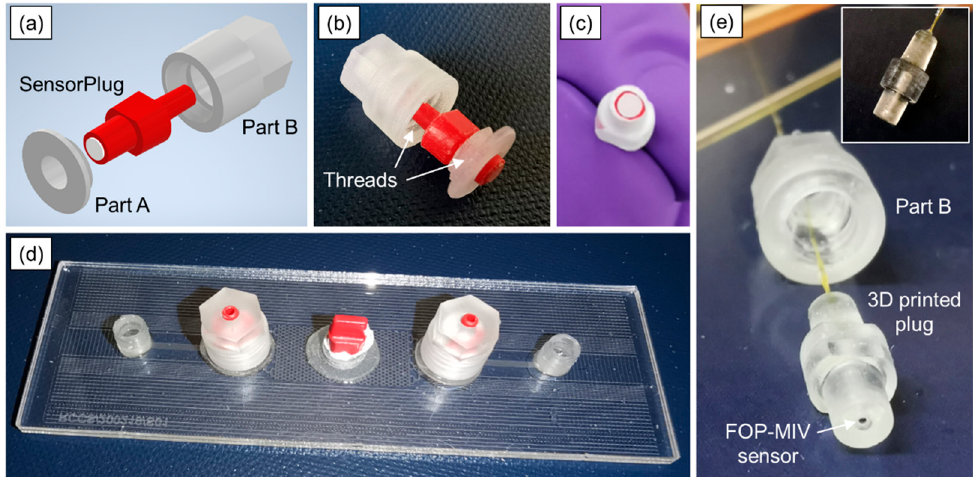
Figure 3. Three-dimensional (3D)-printed connectors used to embed the pH SensorPlugs and FOP- MIV sensors into the ports of the glass microfluidic devices: ( a ) 3D design and ( b ) printed Parts A and B with a fitted pH SensorPlug, ( c ) pH SensorPlug with PTFE tape, ( d ) microfluidic device with all components attached (including the pH SensorPlugs), and ( e ) 3D printed plug with a built-in FOP-MIV sensor.